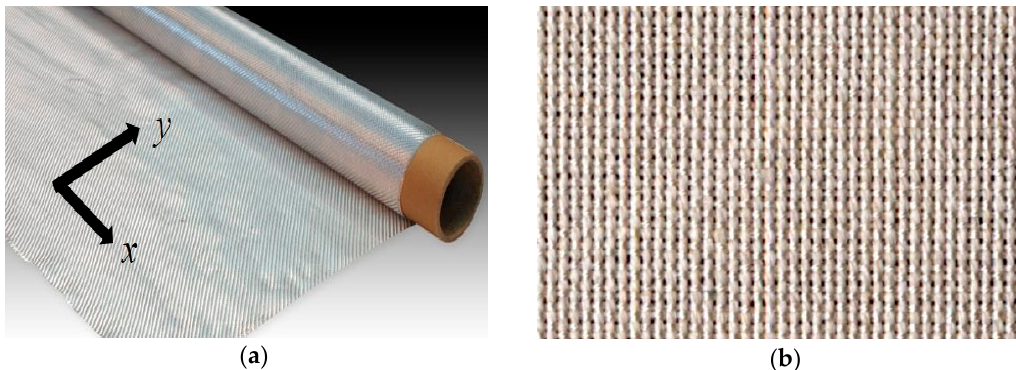
Figure 2. Representative images of the fabric, showing ( a ) longitudinal (abbreviated L for filling and y for testing) and transverse (abbreviated T for filling and x for testing) directions with respect to fabric roll and ( b ) a macroscopic image of the weave pattern.